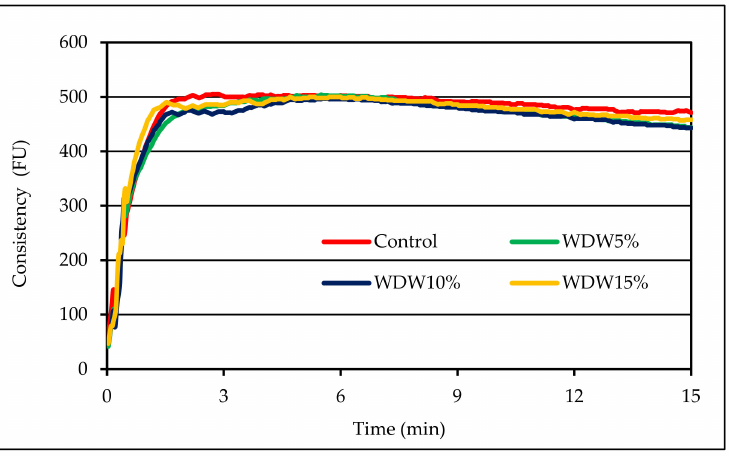
Figure 1. Curves from the farinographic analysis of the tested